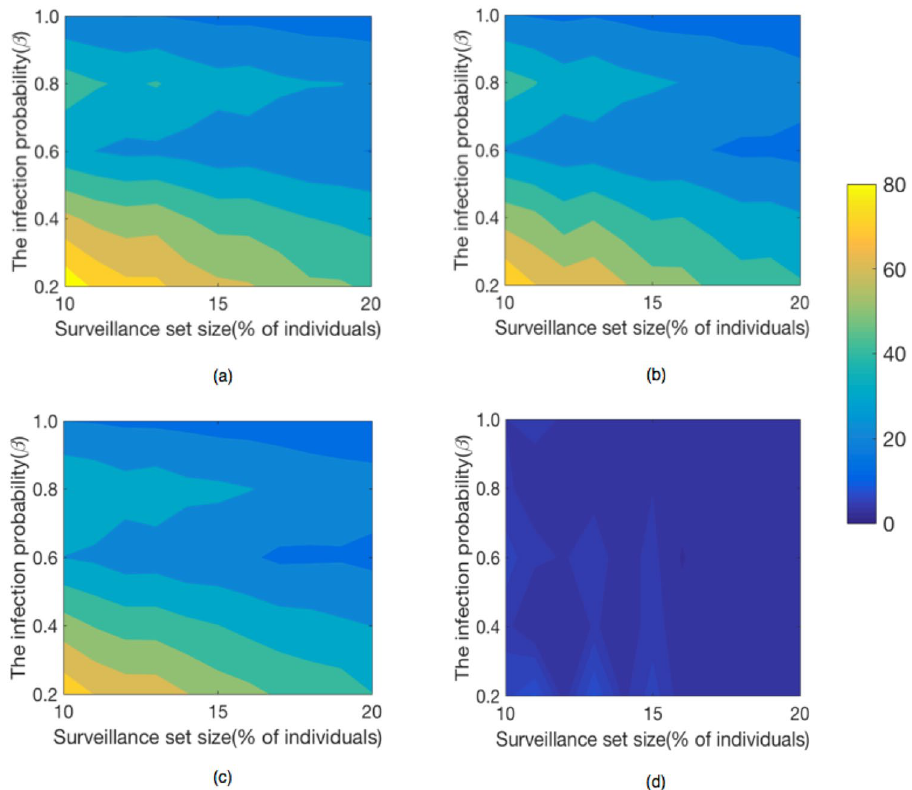
Figure 7. The size of surveillance set and the infection probability impact performance on Prostitution network. The infection lead time improves as the surveillance system expands in the ( a ) Recent , ( b ) Frequent , ( c ) Acquaintance and ( d ) Random